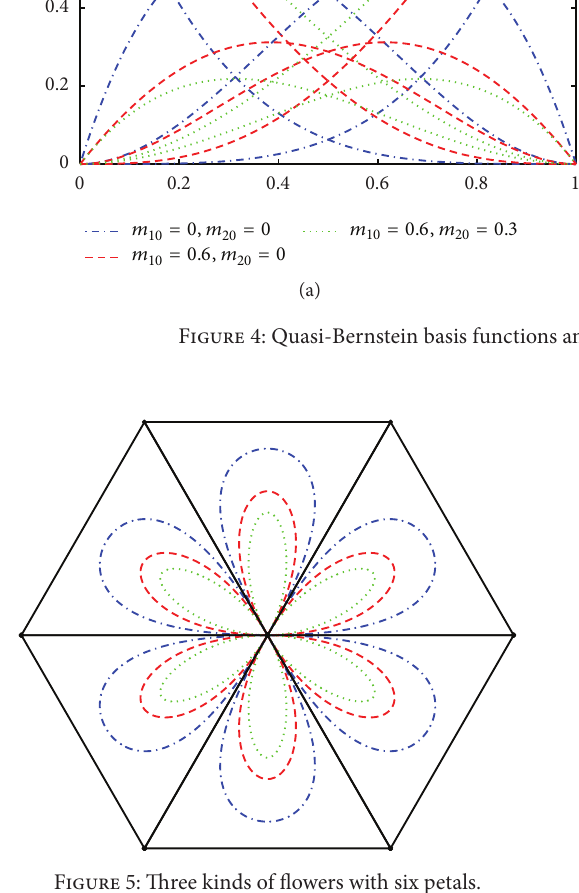
Figure 5: Three kinds of flowers with six petals.